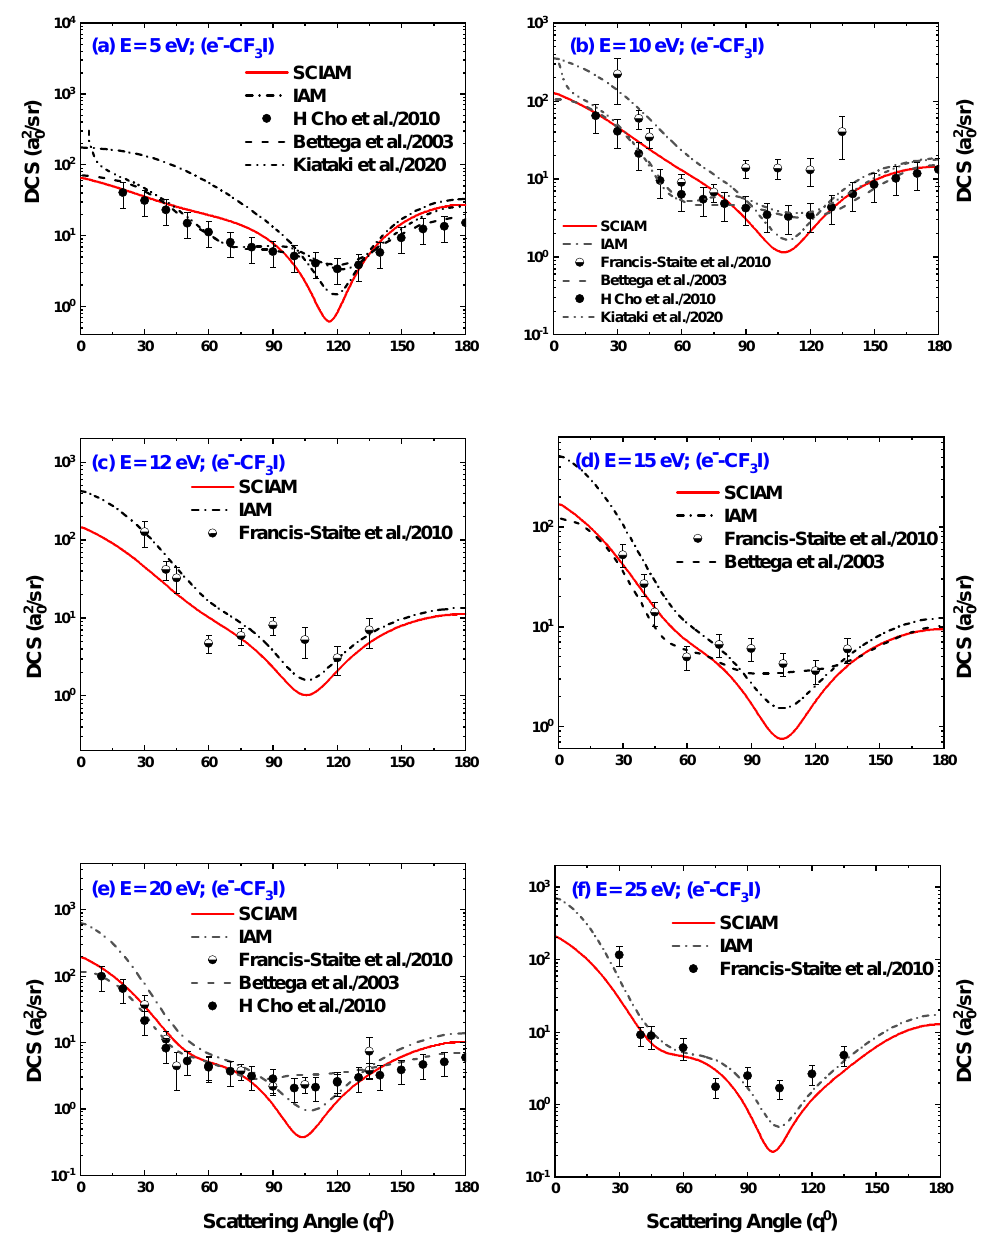
Figure 1. DCS ( a 2 / sr ) for the elastic scattering of electrons from CF 3 I at incident energies 5, 10, 12, 15, 0 20 and 25 eV. Theoretical works: SCIAM, IAM, Bettega et al. [30] and Kiataki et al. [27]. Experimental works: Francis-Staite et al. [25], H Cho et al. [26], and Kitajima et al.